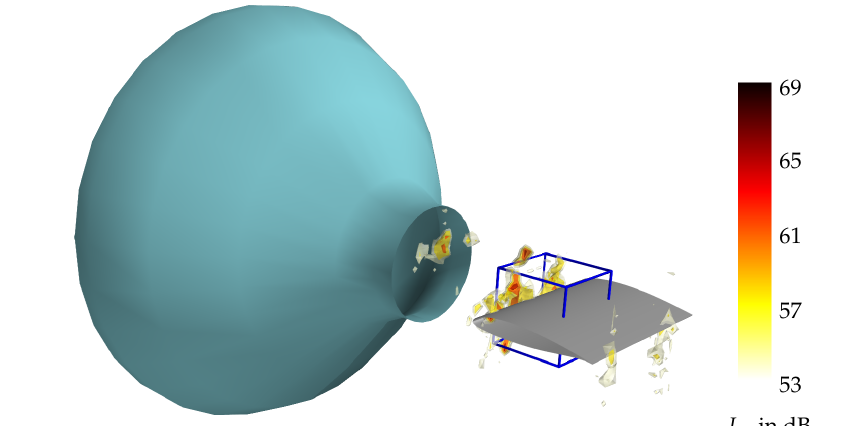
Figure 6. Sample sound map of the noise from the reference airfoil at a Mach number M = 0.21, geometric angle of attack 6 ◦ , 2 kHz octave band, PPS 12/2 turbulence grid (not shown), including the three-dimensional integration sector for noise generated at the leading edge (blue